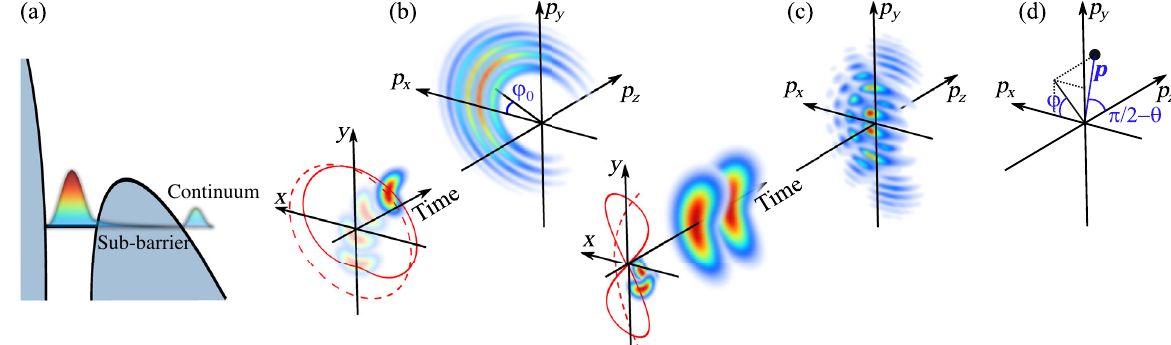
FIG. 1. Schematic view of sub-barrier and continuum electron dynamics in strong-field ionization (a) and principles of chiral attoclock (b) and subcycle gated photoelectron interferometry (c) techniques. In (a), ionization occurs as part of the initial bound electron wave packet tunnels through the target potential barrier lowered by the strong laser field. The released electron is then subject to scattering onto the ionic potential in the continuum. In (b), randomly oriented molecules are ionized by a bicircular corotating two-color laser field E ð t Þ (red continuous line). The dashed red line corresponds to − A ð t Þ , the negative of the vector potential. In the SFA framework, the asymptotic photoelectron angular distribution [here displayed in the ( p x , p y )-polarization plane] would follow the shape of − A ð t Þ and point to φ 0 ¼ 0 . Deviations from this direction can be read as attoclock offsets. In the case of a chiral target, these offsets are forward- backward asymmetric with respect to the light propagation axis z . In (c), the molecules are ionized by an orthogonal two-color laser field (red continuous line). Two electron wave packets are released per half laser cycle, creating an interference pattern in the photoelectron angular distribution. In the case of a chiral target, these interferences present asymmetric features which include information about the impact of chirality on the amplitude and phase profiles of tunneling electron wave packets. We display in (d) the Cartesian and spherical momentum coordinate systems used throughout the